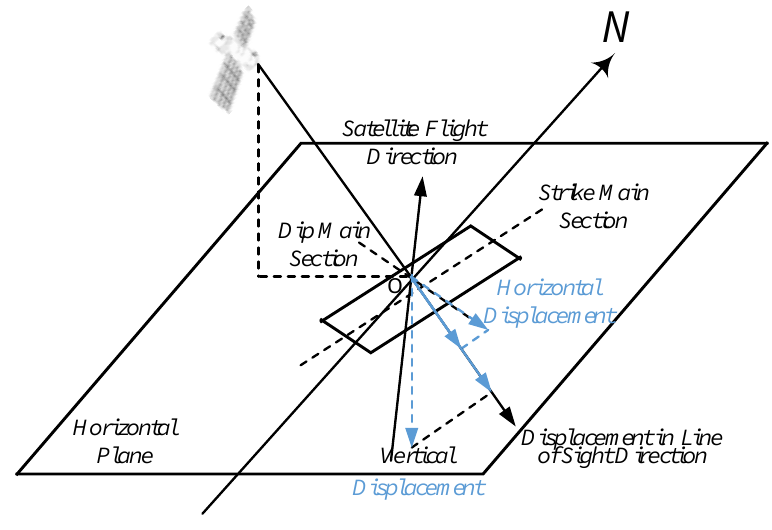
Figure 14. Component of the surface